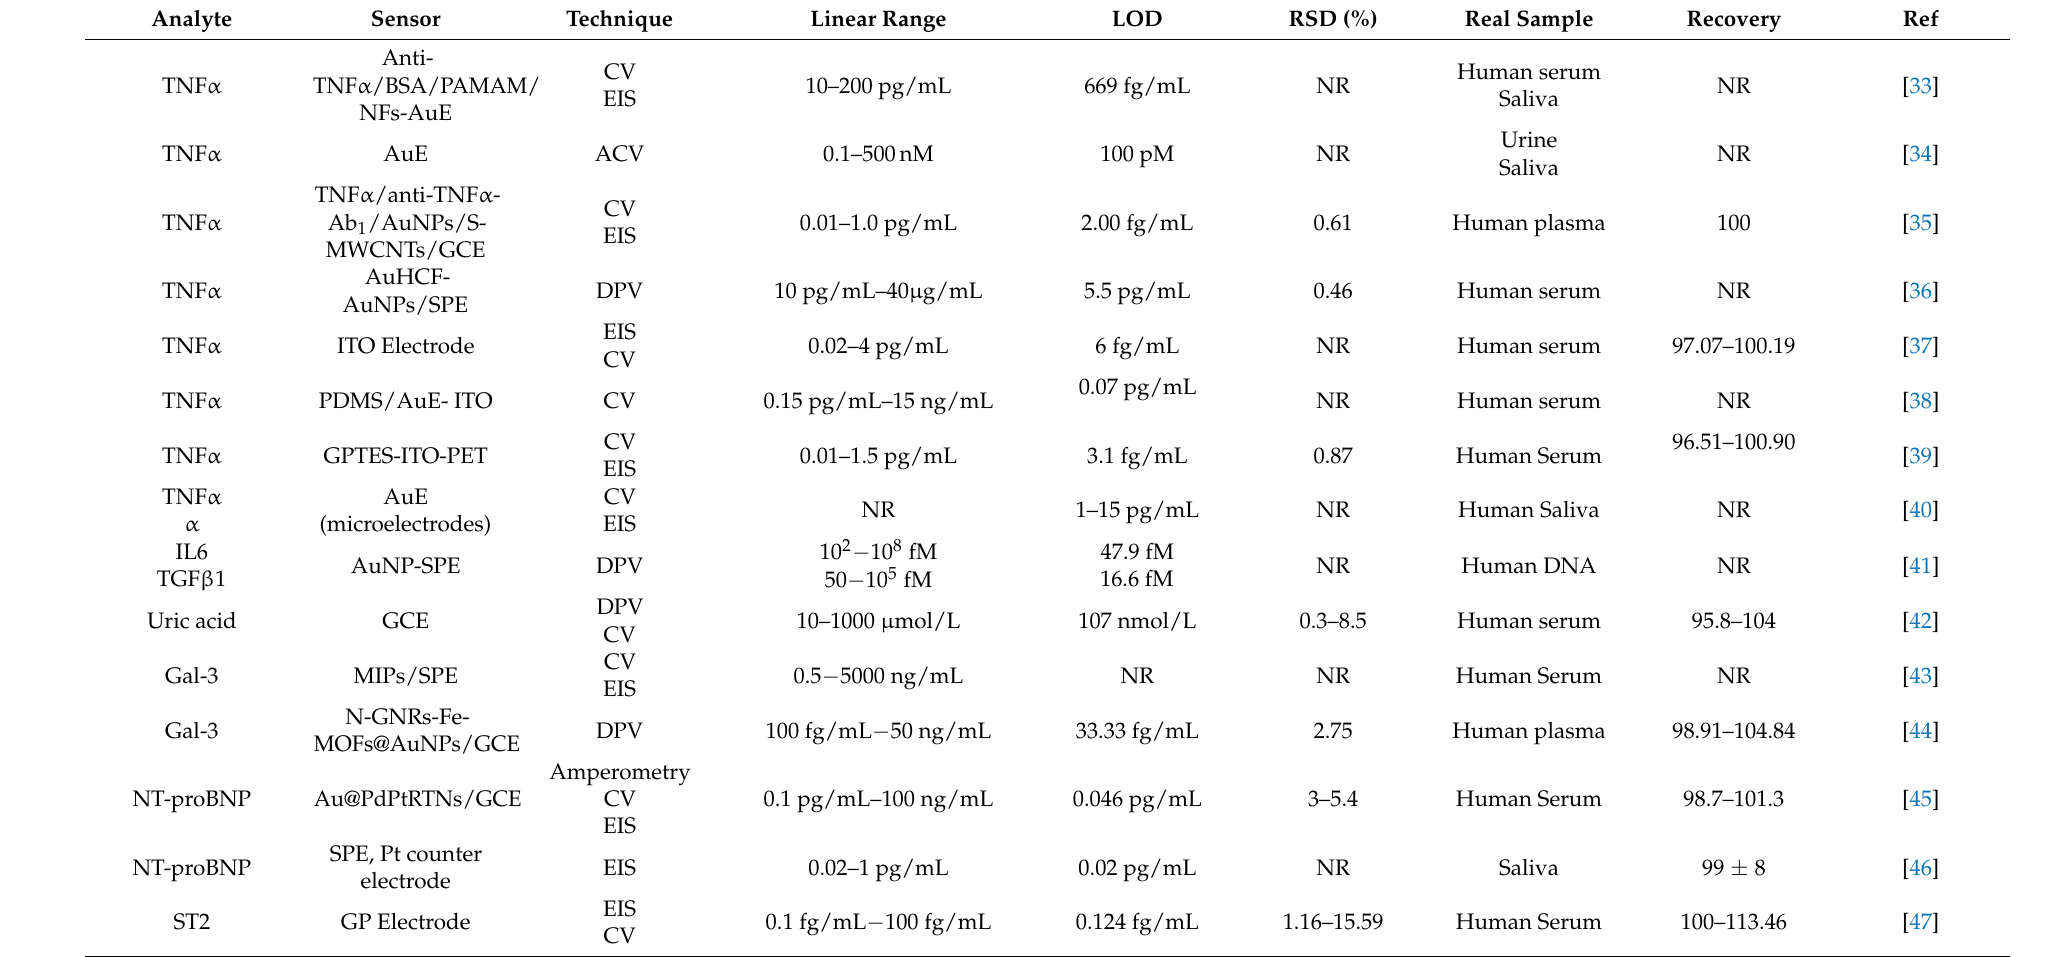
Table 1. Recently developed biosensor-based methods for acute and chronic heart failure